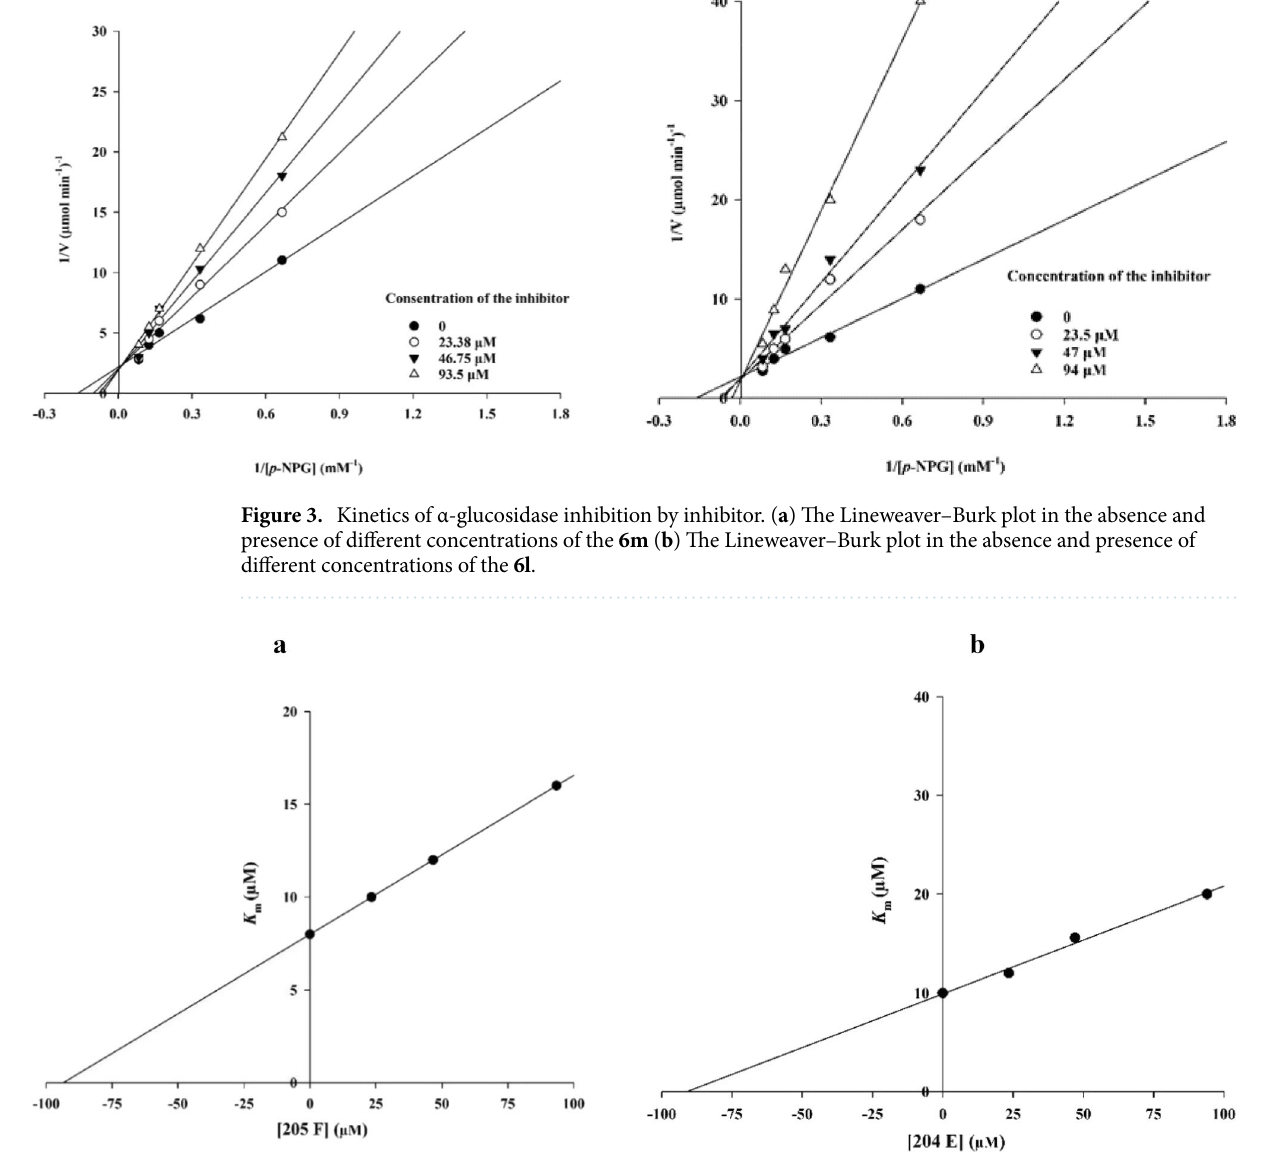
Figure 4. ( a ) The secondary plot between K m and various concentrations of 6m ; ( b ) The secondary plot between K m and various concentrations of 6l